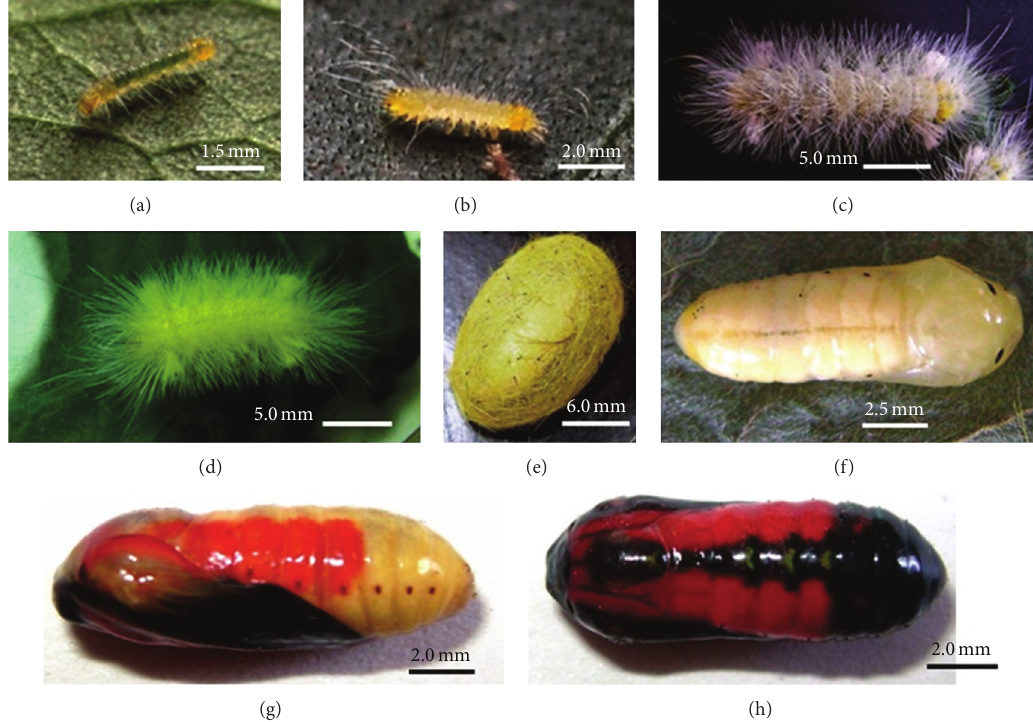
Figure 3: Some immature stages and cocoon of Cosmosoma auge . First instar larva (a), second instar larva (b), last instar larva (c), prepupa (d), cocoon with pupa inside (e), recently molted pupa, dorsal view (f), pupa 12 hours before emersion, lateral view (g), and pupa just before emersion, dorsal view